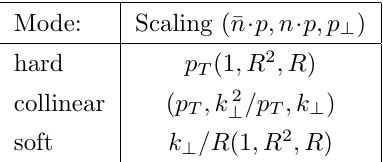
Table 1 . For the angle between the ST and WTA axis, the modes that enter in the factorization of the jet function are listed G